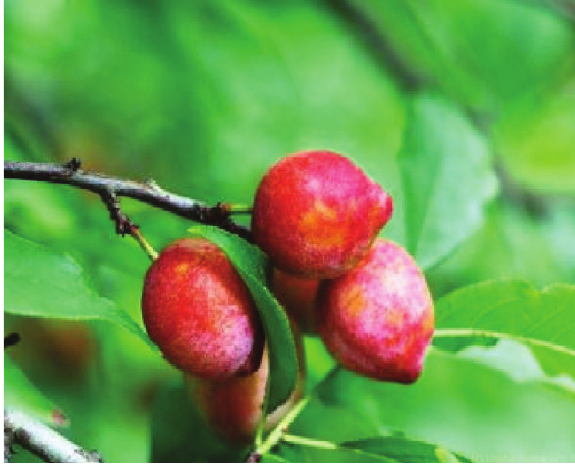
Figure 2: Prunus bokharensis (Plum).